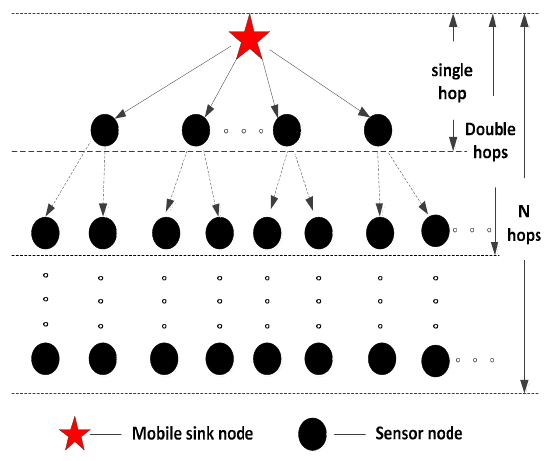
Figure 4. Path key establishment method via the tree-based construction.